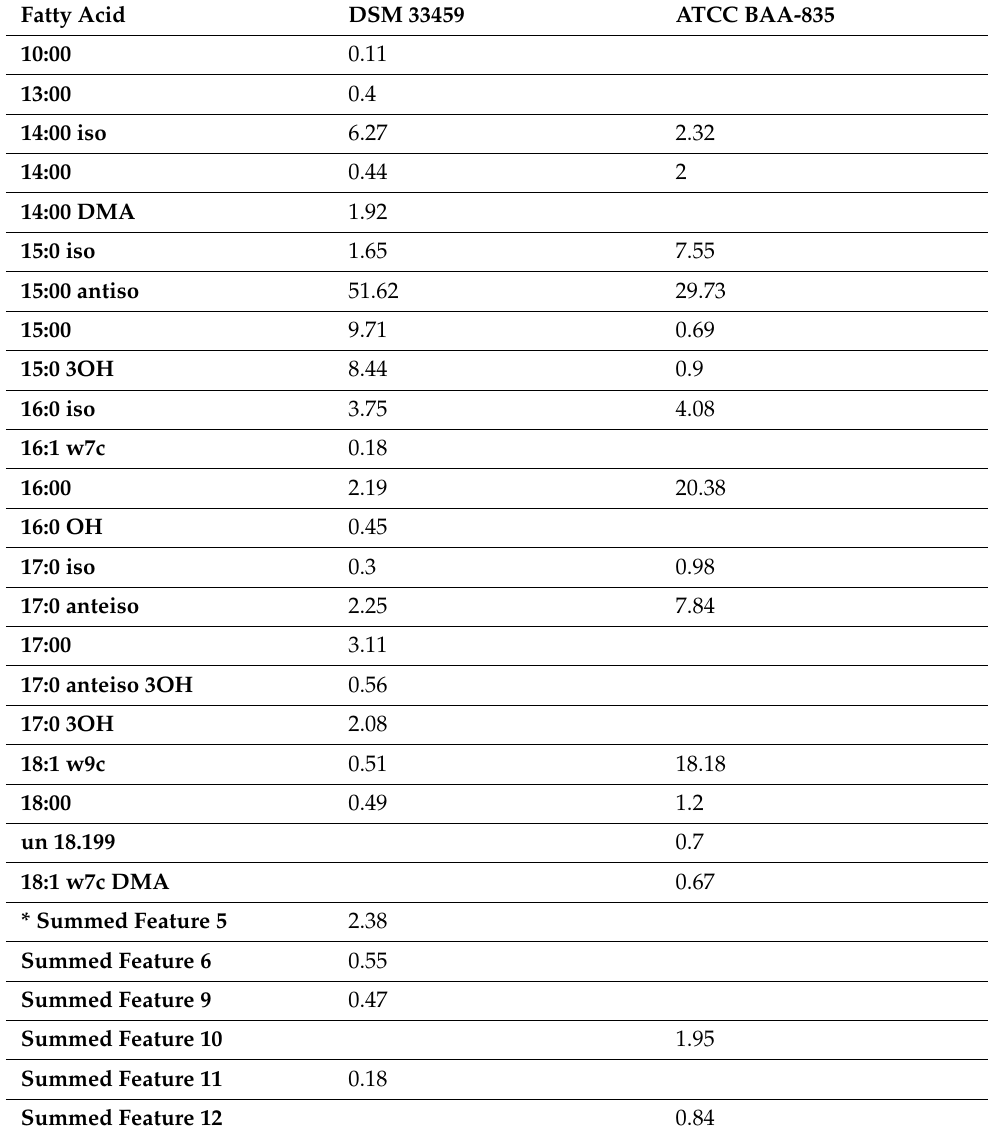
Table 3. Comparative Chemotaxonomic characteristics of the strains Akkermansia sp. DSM 33459